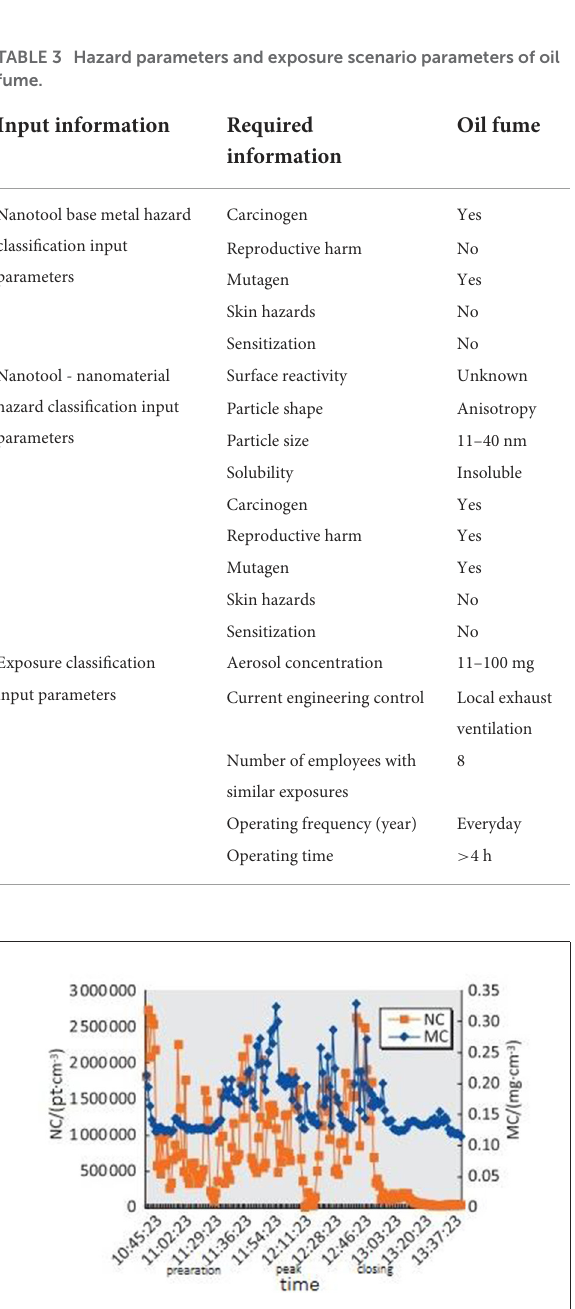
FIGURE2 Distribution of NC 10 − 500nm and MC 10 − 500nm of fried food posts in the Chinese kitchen in different time periods.